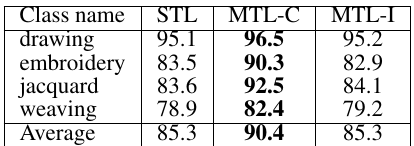
Table 4. F1-Scores [%] for the task production place (first series of experiments).